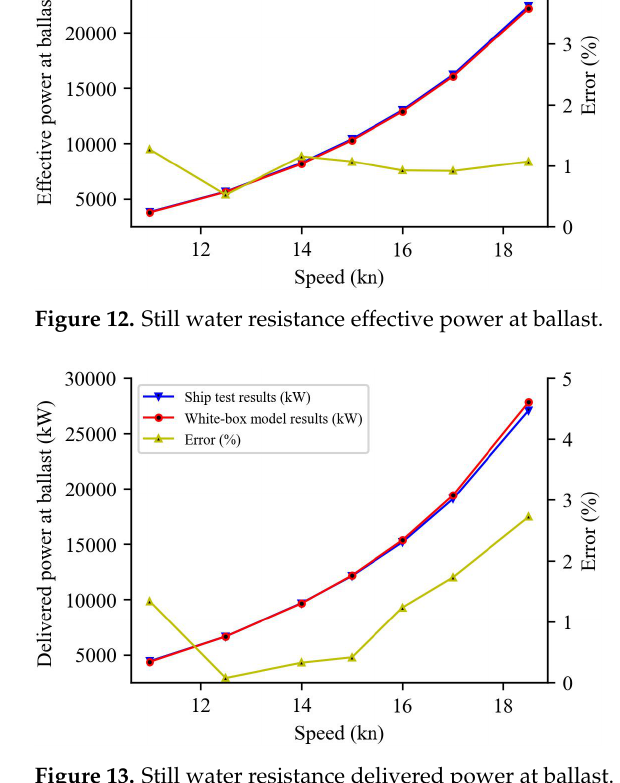
Figure 13. Still water resistance delivered power at ballast.